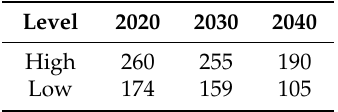
Table 2. Rotational energy in the NPS (GW · s) for the period 2020–2040.